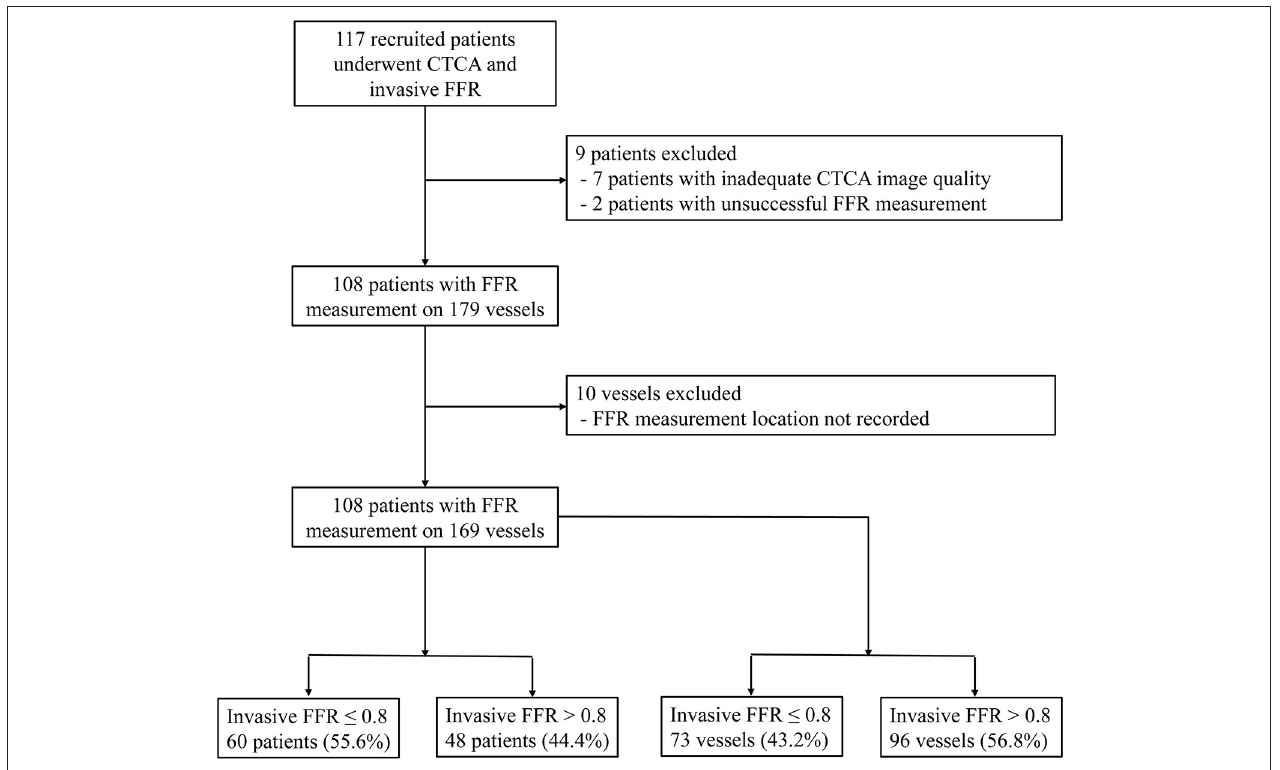
FIGURE 1 | Study inclusion flowchart. CTCA, CT coronary angiography; FFR, fractional flow